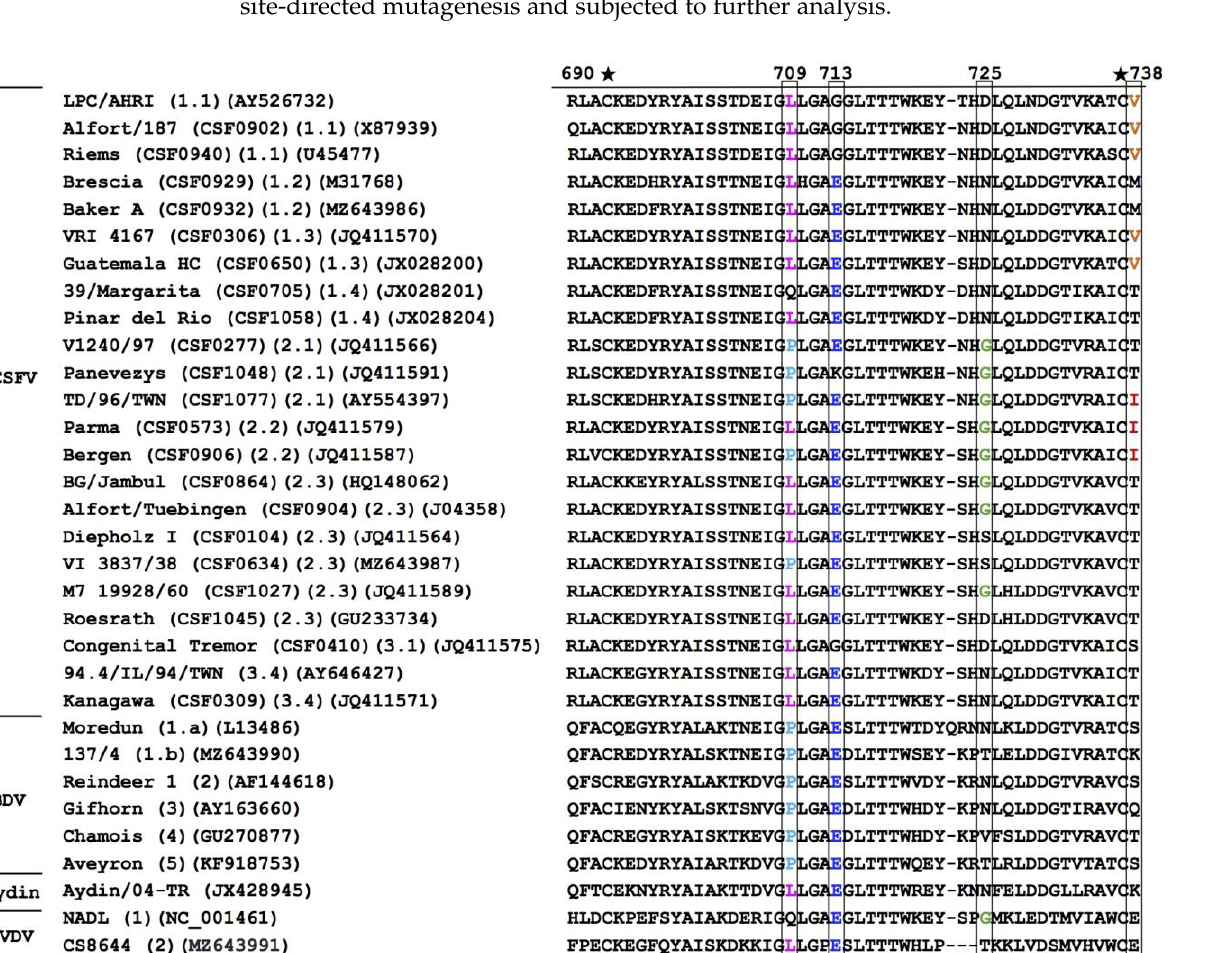
Figure 3. Alignment of the amino acid sequences of residues 690–738 of pestivirus glycoprotein E2. The positions of amino acid residues are numbered based on those of CSFV strain TD/96/TWN. Sequences are clustered based on their allocation to genotypes as in Table 1. For each virus strain the genotype and the accession number are indicated. The key residues which might be responsible for the reactivity patterns of the mAbs characterized in this study are boxed and highlighted with different colors. The residues P709, L709, E713, G725, V738 and I738 are highlighted with light blue, pink, blue, green, orange and red, respectively. Cysteine residues are indicated by an asterisk above the alignment.